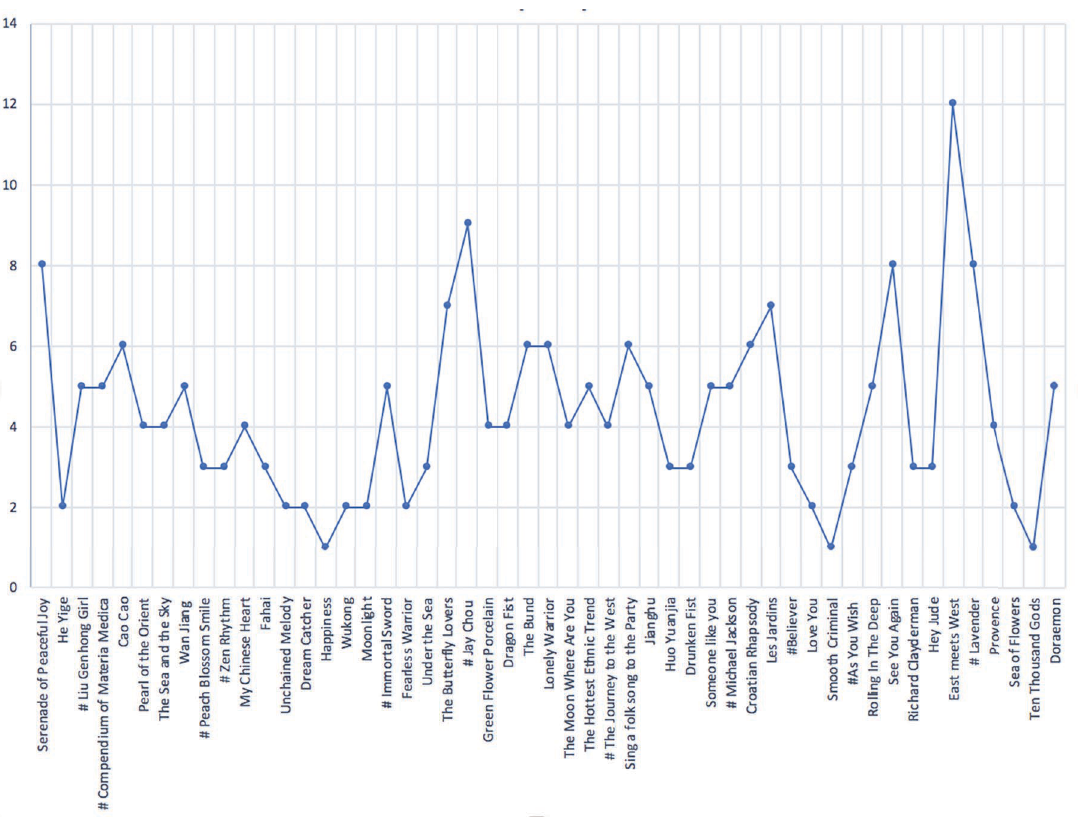
Figure 1. The Frequency of Songs Mentioned in Peng’s